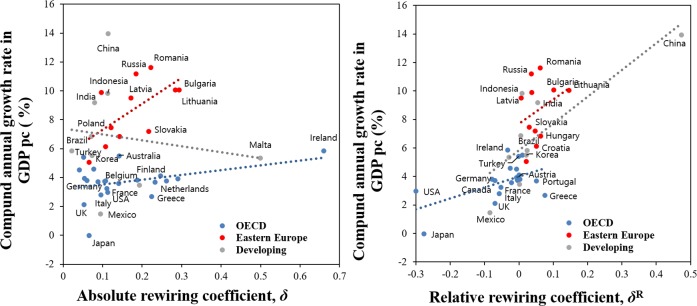
Plot of the relationship between the rewired measures and compound annual growth rate in GDP/capita for 42 countries.Early OECD member countries before 1990 (Blue) and Eastern Europe countries (Red) are highlighted. Other developing nations shown in gray. GDP data are in constant 2010 U.S. dollars from the World Bank.